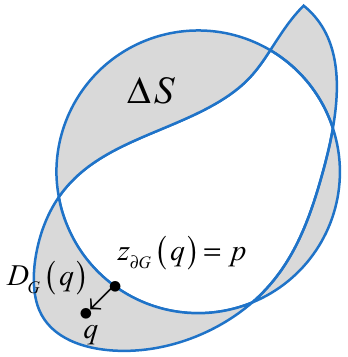
point z ∂ G ( q ) on the boundary ∂ G .